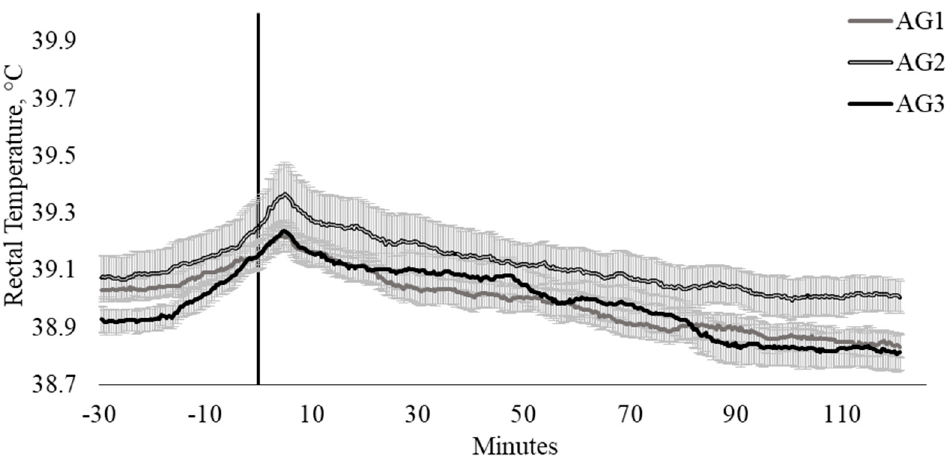
Figure 4. Twenty-seconds mean (±SEM) rectal temperature (T REC , °C) of cattle with agitometer scores ≤ 33 (AG1; n = 16; ♀ = 6, ♂ = 10); 45 ≤ 82 (AG2; n = 15; ♀ = 10, ♂ = 5); and ≥ 86 (AG3; n = 14; ♀ = 6, ♂ = 8).